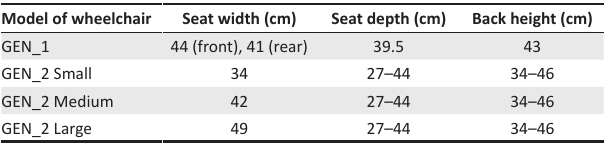
FIGURE 1: The FWM GEN_1 wheelchair. TABLE 1: Dimensions of wheelchair models and sizes. Model of wheelchair